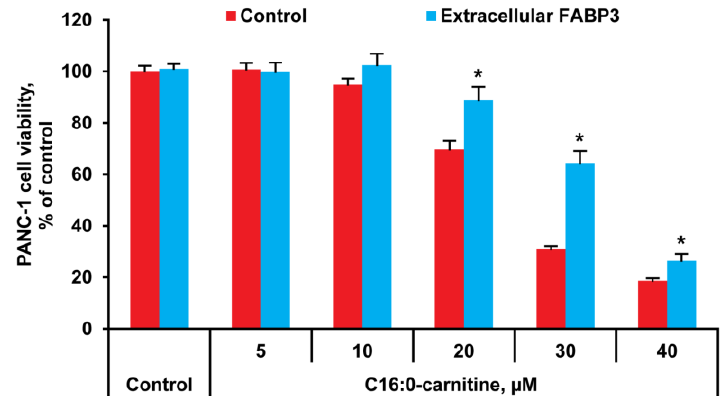
Figure 2. Toxicity of C16:0-carnitine in PANC-1 cells after 4 h of incubation in the presence or in the absence of 60 µ M heart-type fatty acid-binding protein (FABP3) in the cell media. Data are shown as the mean ± SEM of 3 independent experiments in at least 6 technical replicates. * indicates a significant difference compared to the cells not subjected to FABP3 treatment at the respective C16:0-carnitine concentration.